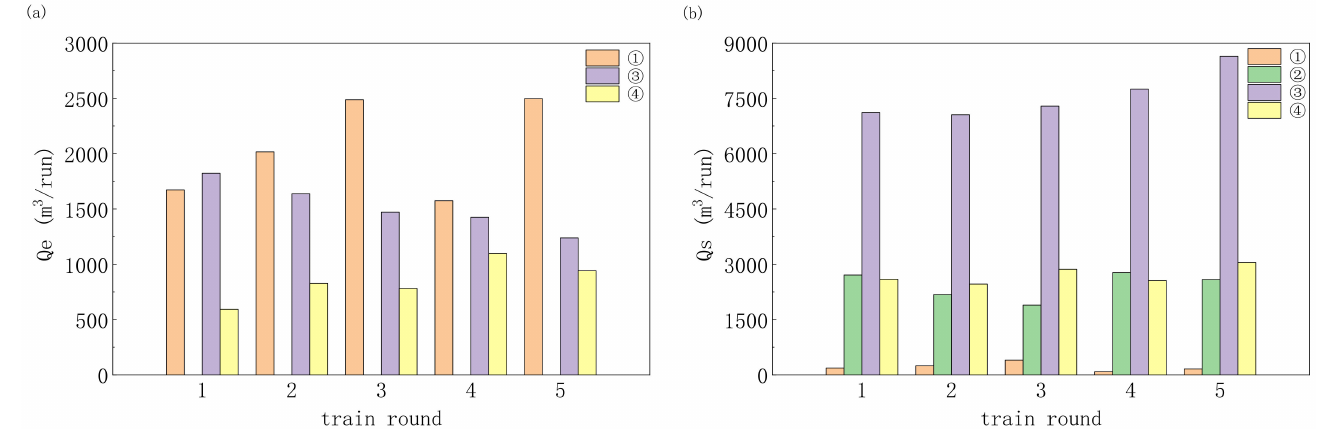
Figure 9. ( a ) Effective exhaust air volume ( Q e ) of each air shaft per train; ( b ) Effective suction air volume ( Q s ) of each air shaft per train.